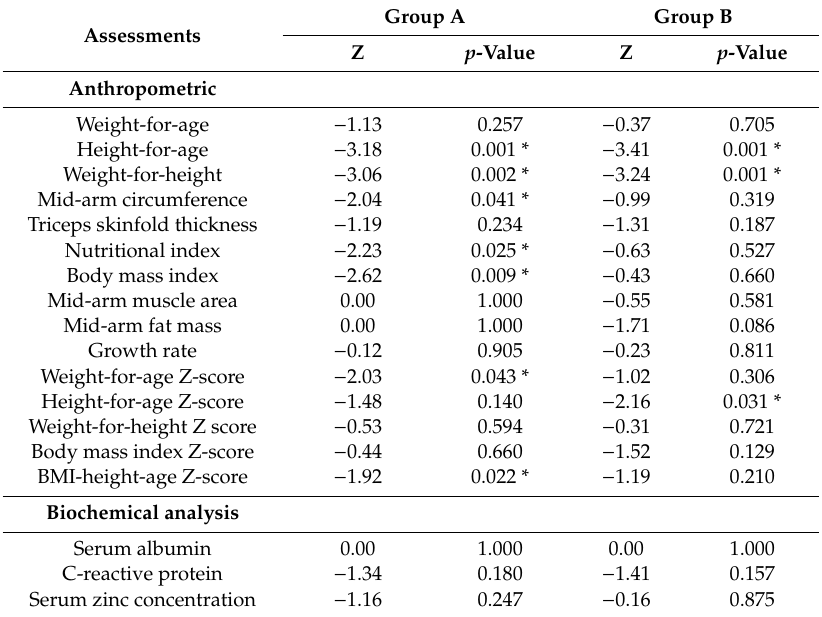
Table 5. Statistical changes by groups of treatment after zinc supplementation ( n =